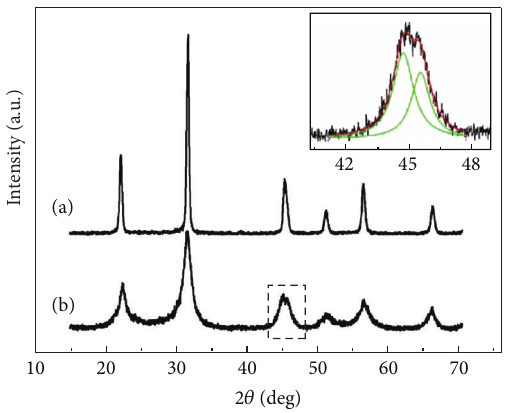
Figure 1: XRD patterns of (a) nanoparticles and (b) nanowires of KNbO 3 . Inset: the Lorentz fitting for diffraction peak of KNbO 3 nanowires located at 2 𝜃 of ∼ 45 ∘